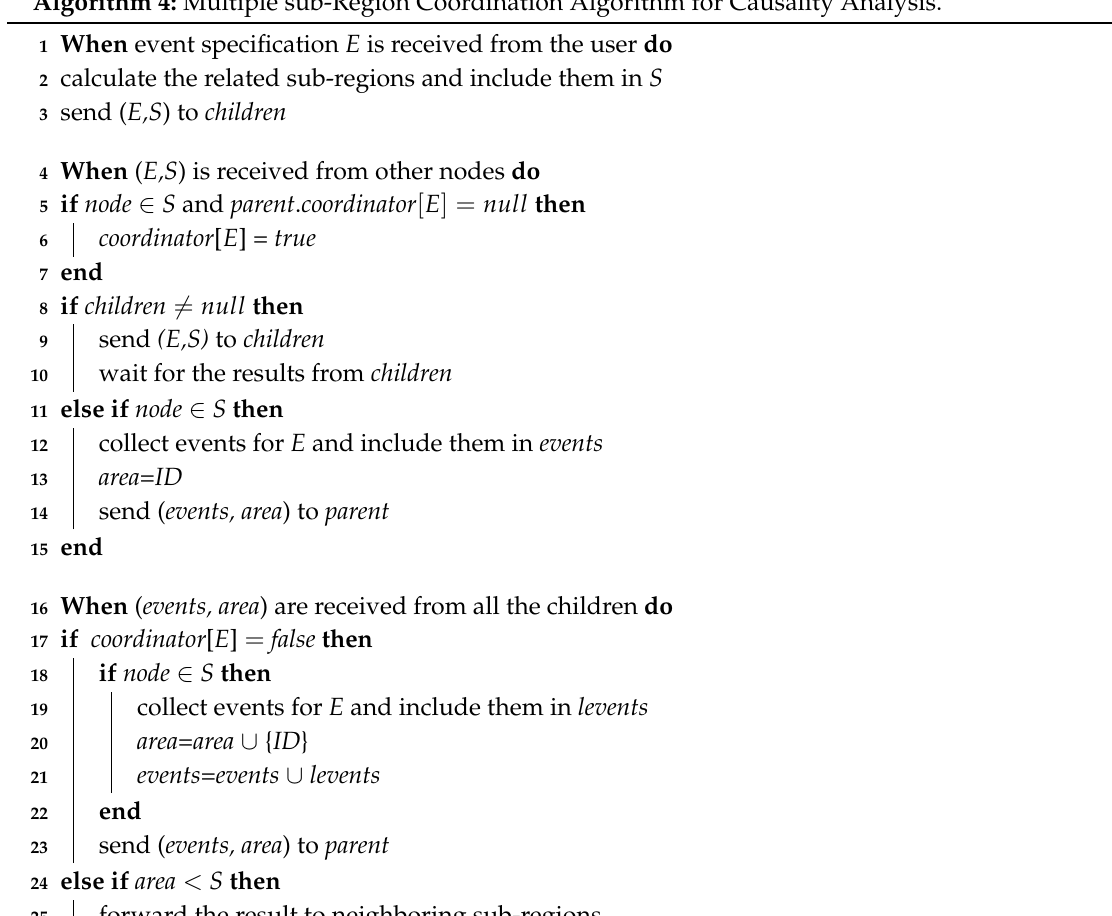
Algorithm 4: Multiple sub-Region Coordination Algorithm for Causality